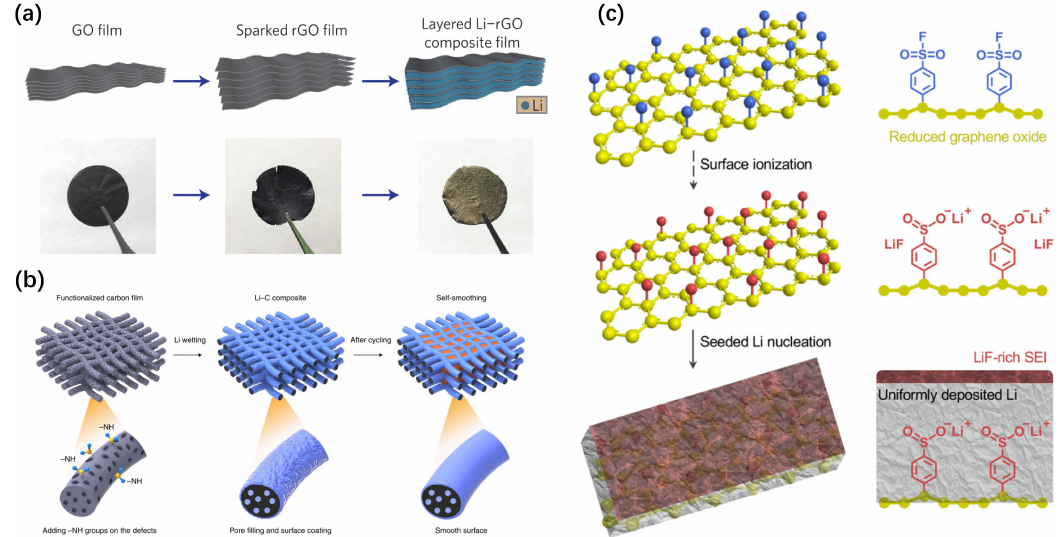
Figure 9. ( a ) Preparation of the layered Li-rGO composite film [108]. ( b ) Schematic illustration of the stabilized lithium deposition interface using the active organic molecule benzenesulfonyl fluoride (BSF) [121]. ( c ) Schematic illustration of the self-smoothing behavior of the lithium–carbon anode [106].